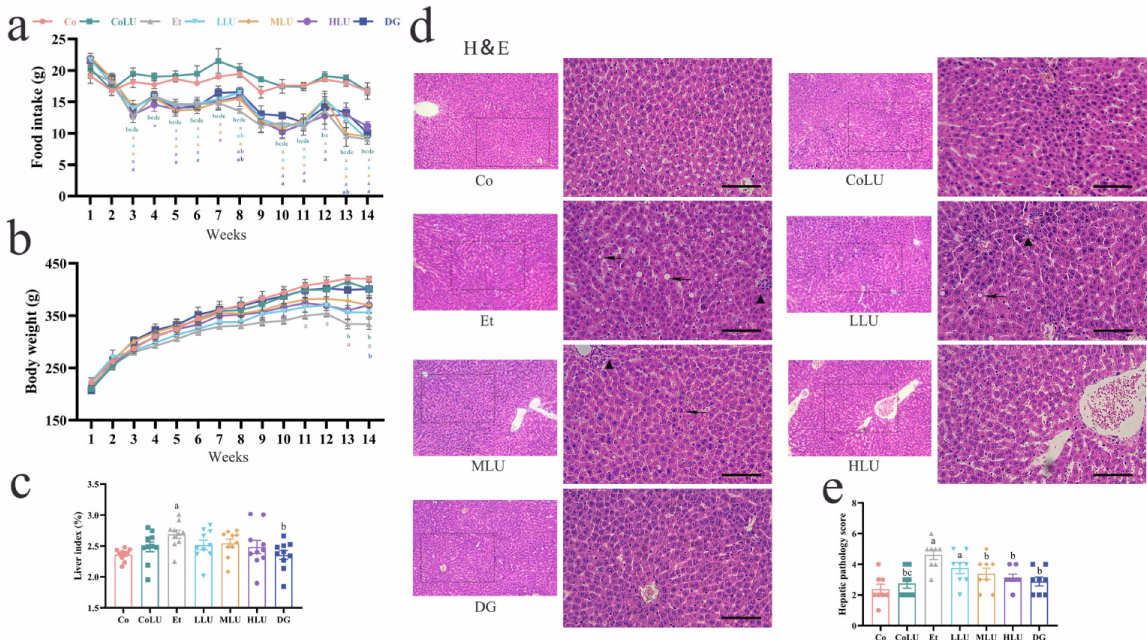
Figure 1. Effects of lutein on food intake, body weight and liver tissue. Changes in food intake ( a ) and body weight ( b ) during the experimental period. ( c ) Index of the liver ( n = 10/group). Liver H&E staining ( d ) (scale bar = 50 µ m, magnification 200 × and 400 × ; black arrows indicate hepatocyte fat vacuoles, and black triangles suggest inflammatory cell aggregates; n = 8/group) and Hepatic pathology score ( e ) (magnification 200 × ; n = 8/group). The data were shown with mean ± SEM. Co: normal control group; CoLU: the medium-dose lutein control group; Et: ethanol model group; LLU: the low-dose lutein intervention group; MLU: the medium-dose lutein intervention group; HLU: the high-dose lutein intervention group; DG: positive control group. a p < 0.05 vs. Co group, b p < 0.05 vs. Et group, c p < 0.05 vs. LLU group, d p < 0.05 vs. MLU group, e p < 0.05 vs. HLU